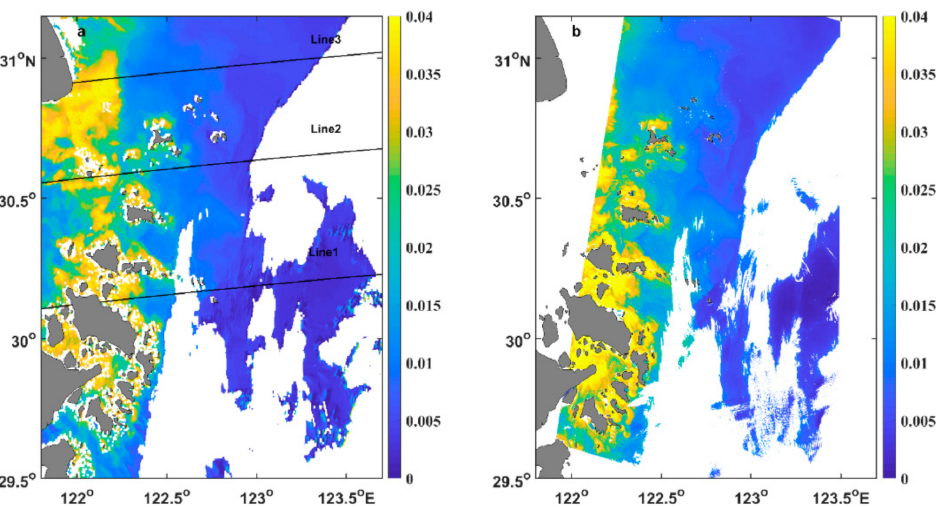
Figure 4. GOCI-derived R rs (660) ( a ) versus Landsat 8 Operational Land Imager (L8/OLI)-derived R rs (655) ( b ). The white areas represent cloud coverage or missing data. Three transects (marked as line1, line2, and line3) were used for the cross-validation between GOCI-retrieved R rs and L8/OLI